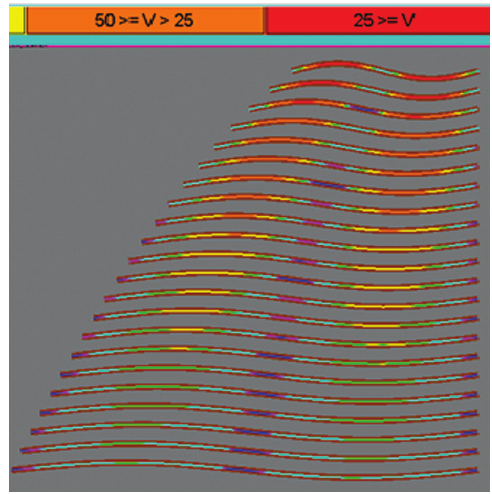
Figure 4 Simulation results of fiber steering trial 2.